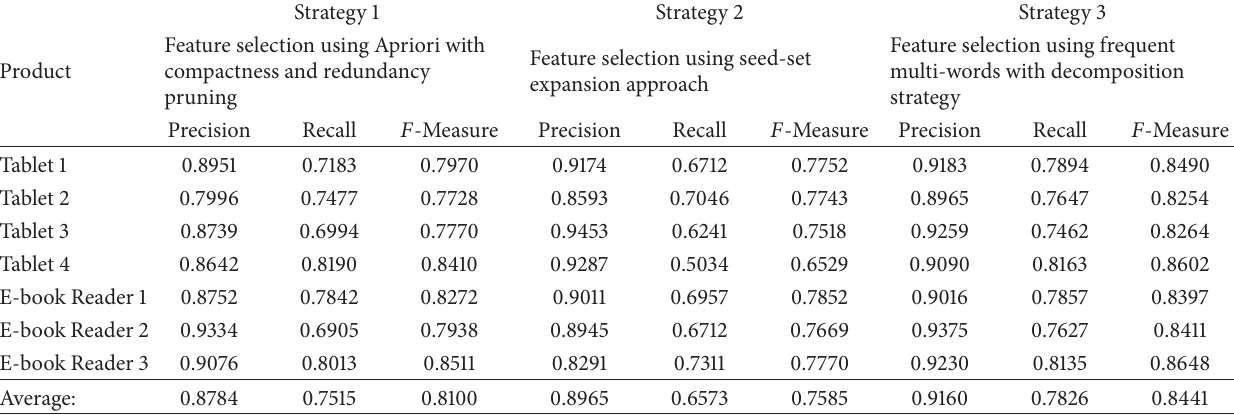
Table 3: Accuracy of opinionated sentence identification using mined product features: performance comparison of 3 strategies.